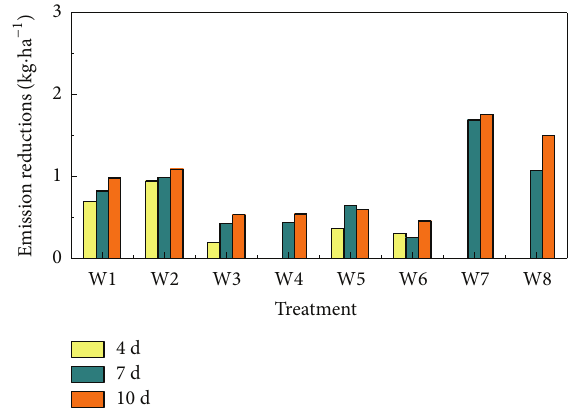
Figure 5: N emission reductions of PFCD